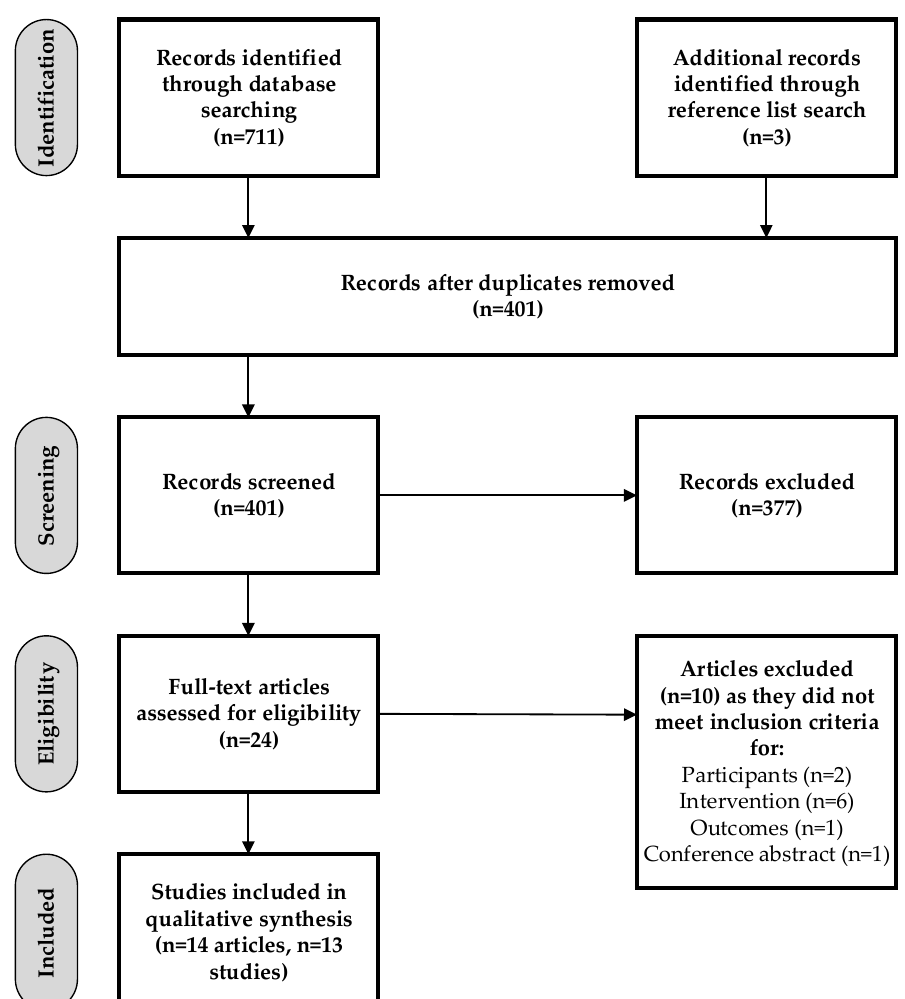
Figure 1. Flow diagram of included studies.